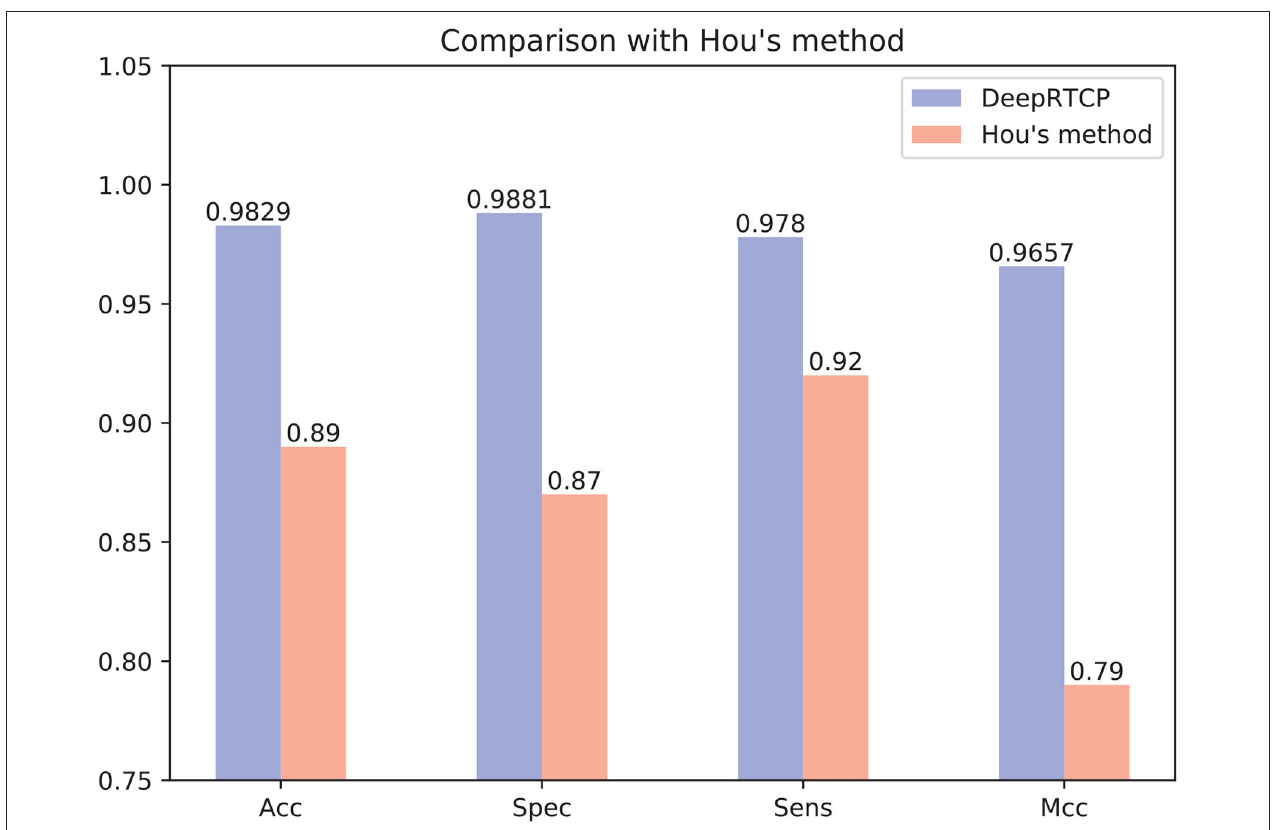
FIGURE 10 | Comparison between DeepRTCP and other